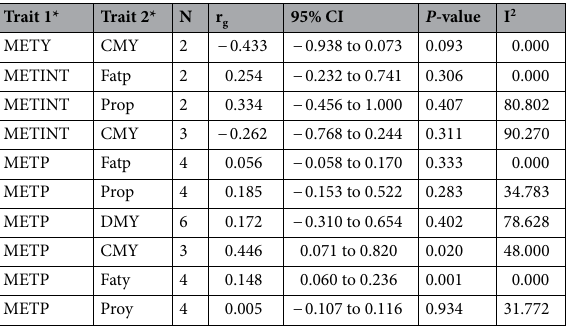
Table 4. Effect size and heterogeneity of the genetic correlation estimates between methane emission traits with production traits in dairy cows obtained from the three-level model of meta-analysis. *For traits, see Table 2. r g : Genetic correlation.